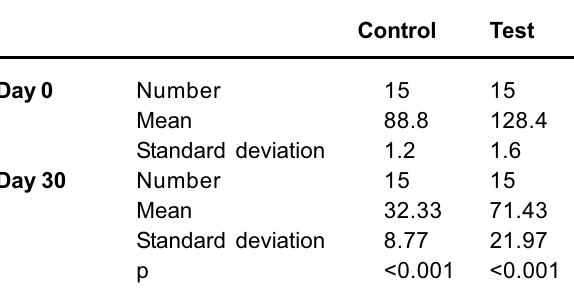
TABLE 1- Weights of dentifrice tubes (in g) means and standard deviation for the control and test groups